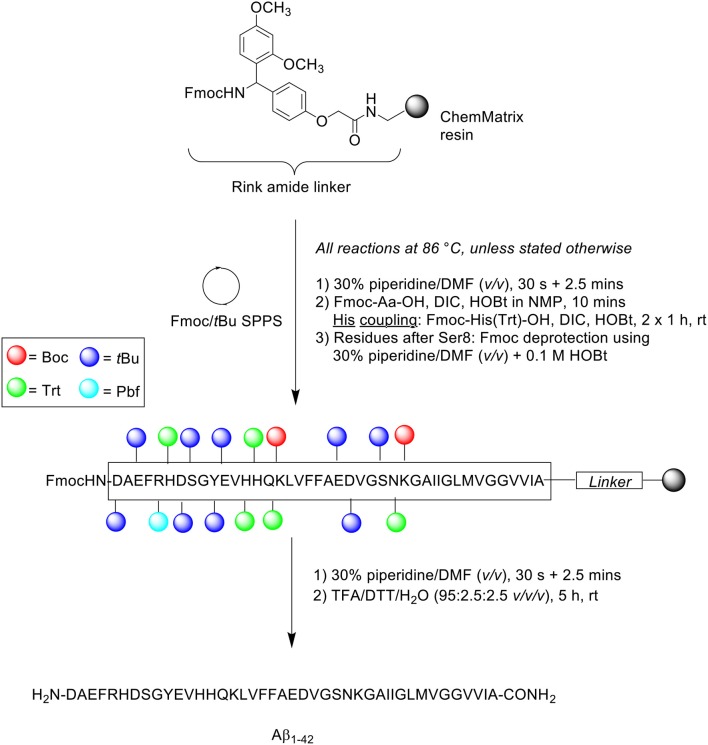
Microwave-assisted Fmoc/tBu SPPS of Aβ1−42 by Bacsa et al. (2010).